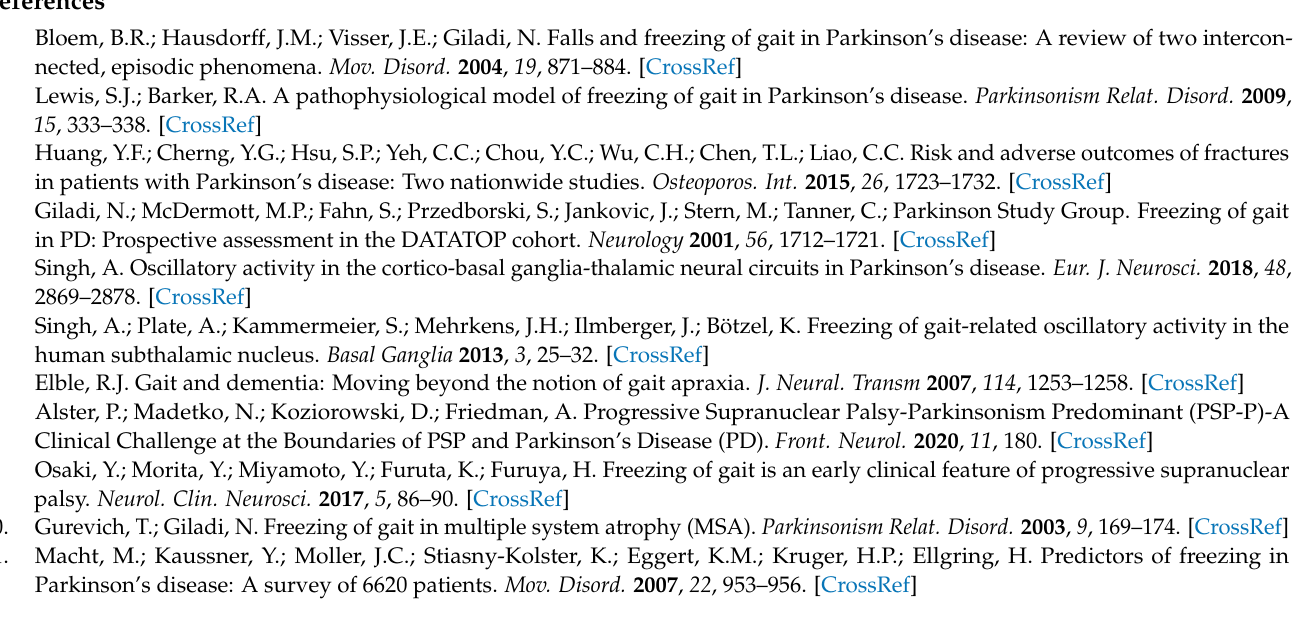
nitive measurement scores, Figure S2: Linear regression analysis and predicted responses between disease duration and FOG severity and cognitive assessment (MoCA) scores, Table S1: Cognitive Measurements between PDFOG+ and PDFOG- controlling for